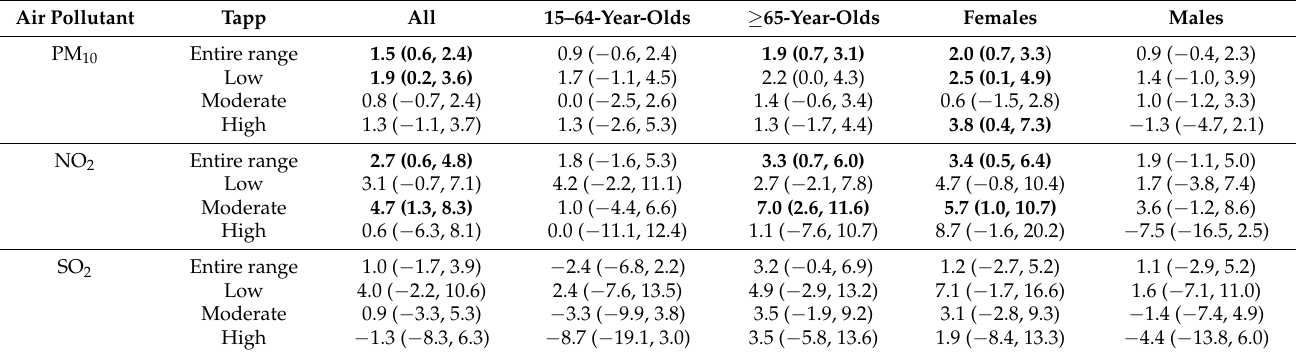
Table 3. One-pollutant model results for the percentage change (95% CI) in daily